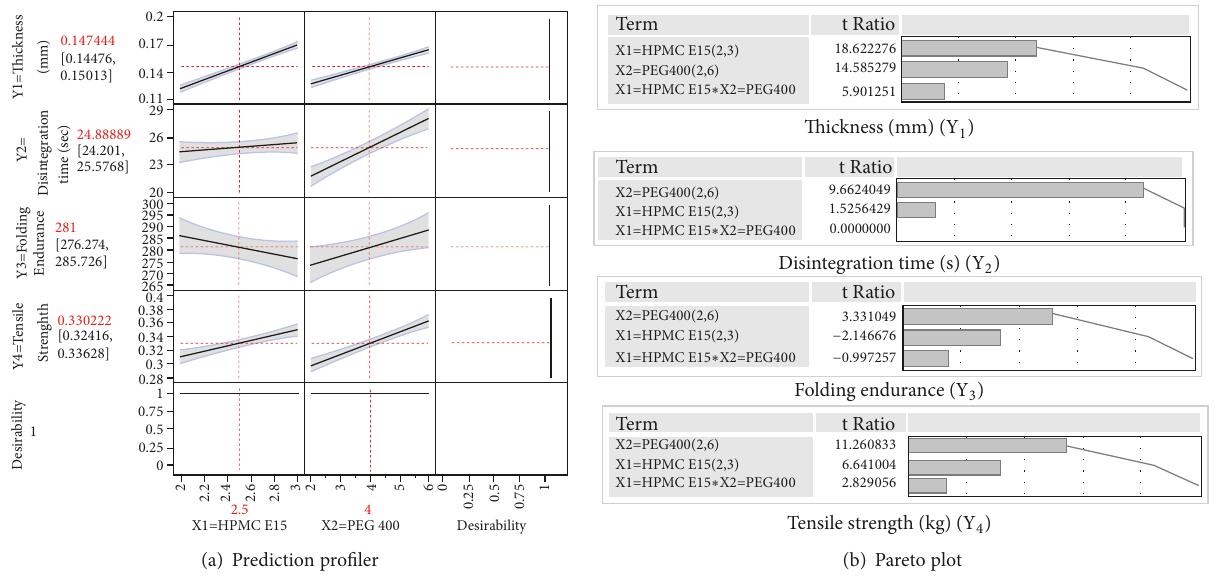
Figure 4: Prediction profiler (4(a)) and standard Pareto plot (4(b)) illustrating the effects HPMC HPMC E 15 (X 1 ) and PEG 400 (X 2 ) on thickness, disintegration time, folding endurance, and tensile strength. The black lines denote the prediction trace; the dotted perpendicular red line corresponds to the current concentration of factor; and the value in red on vertical axis is predicted response based on the current concentration of